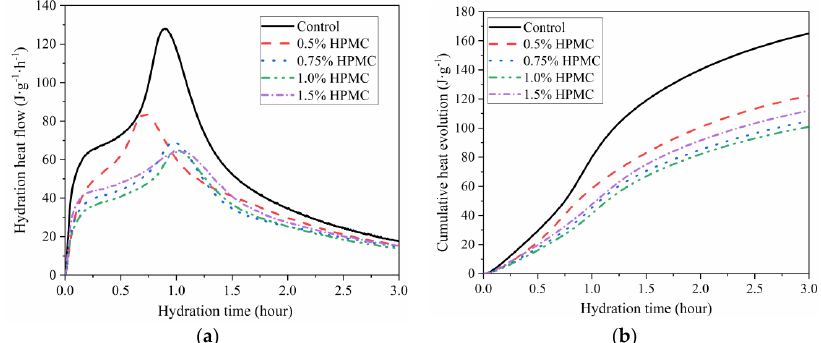
Figure 2. Hydration heat calorimetry of fresh mixed SAC paste with and without HPMC at W/C ratio of 0.40: ( a ) Hydration heat flow during first 3 h of hydration; ( b ) cumulative hydration heat during first 3 h of hydration.